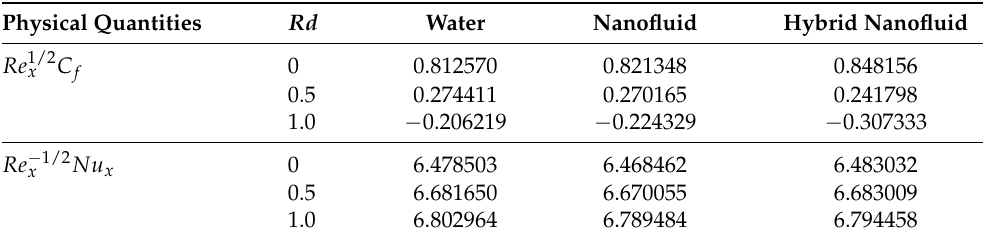
Table 5. Values of Re 1/2 x C f and Re − 1/2 x Nu x for Rd and several types of fluids when S = 1.0, λ = − 8.0 and Pr = 6.2.